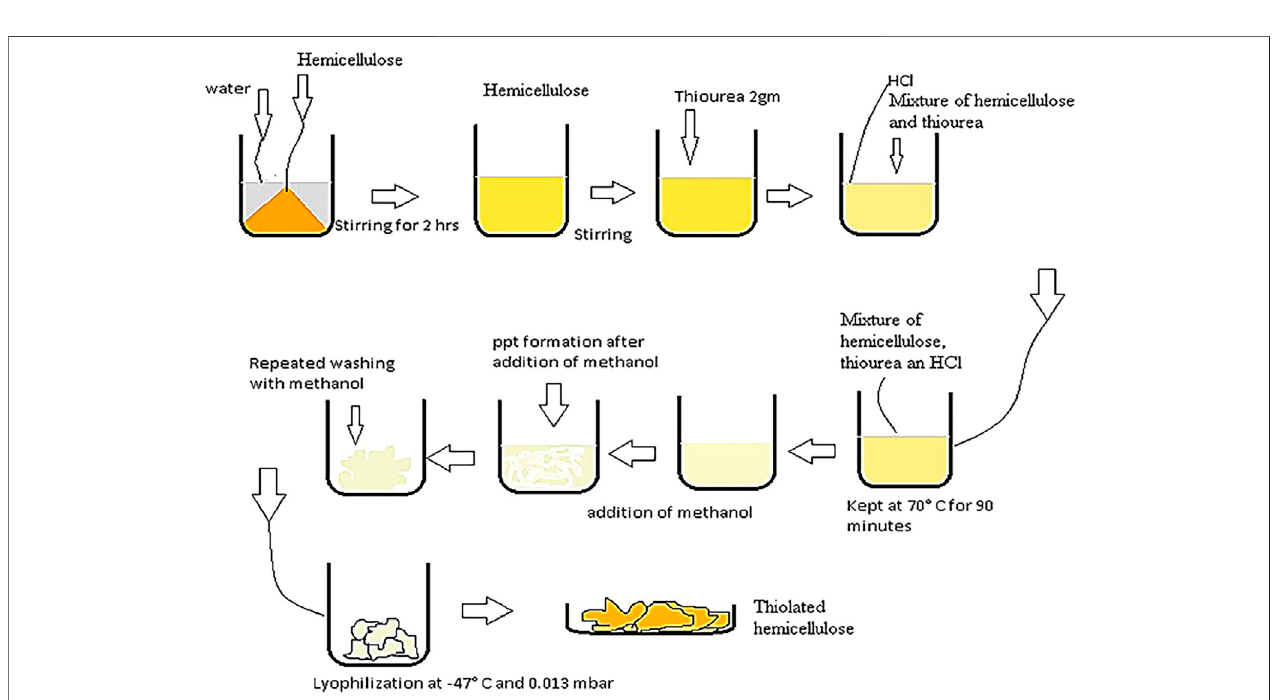
FIGURE 2 | Schematic diagram, describing the process for thiolation of hemicellulose.